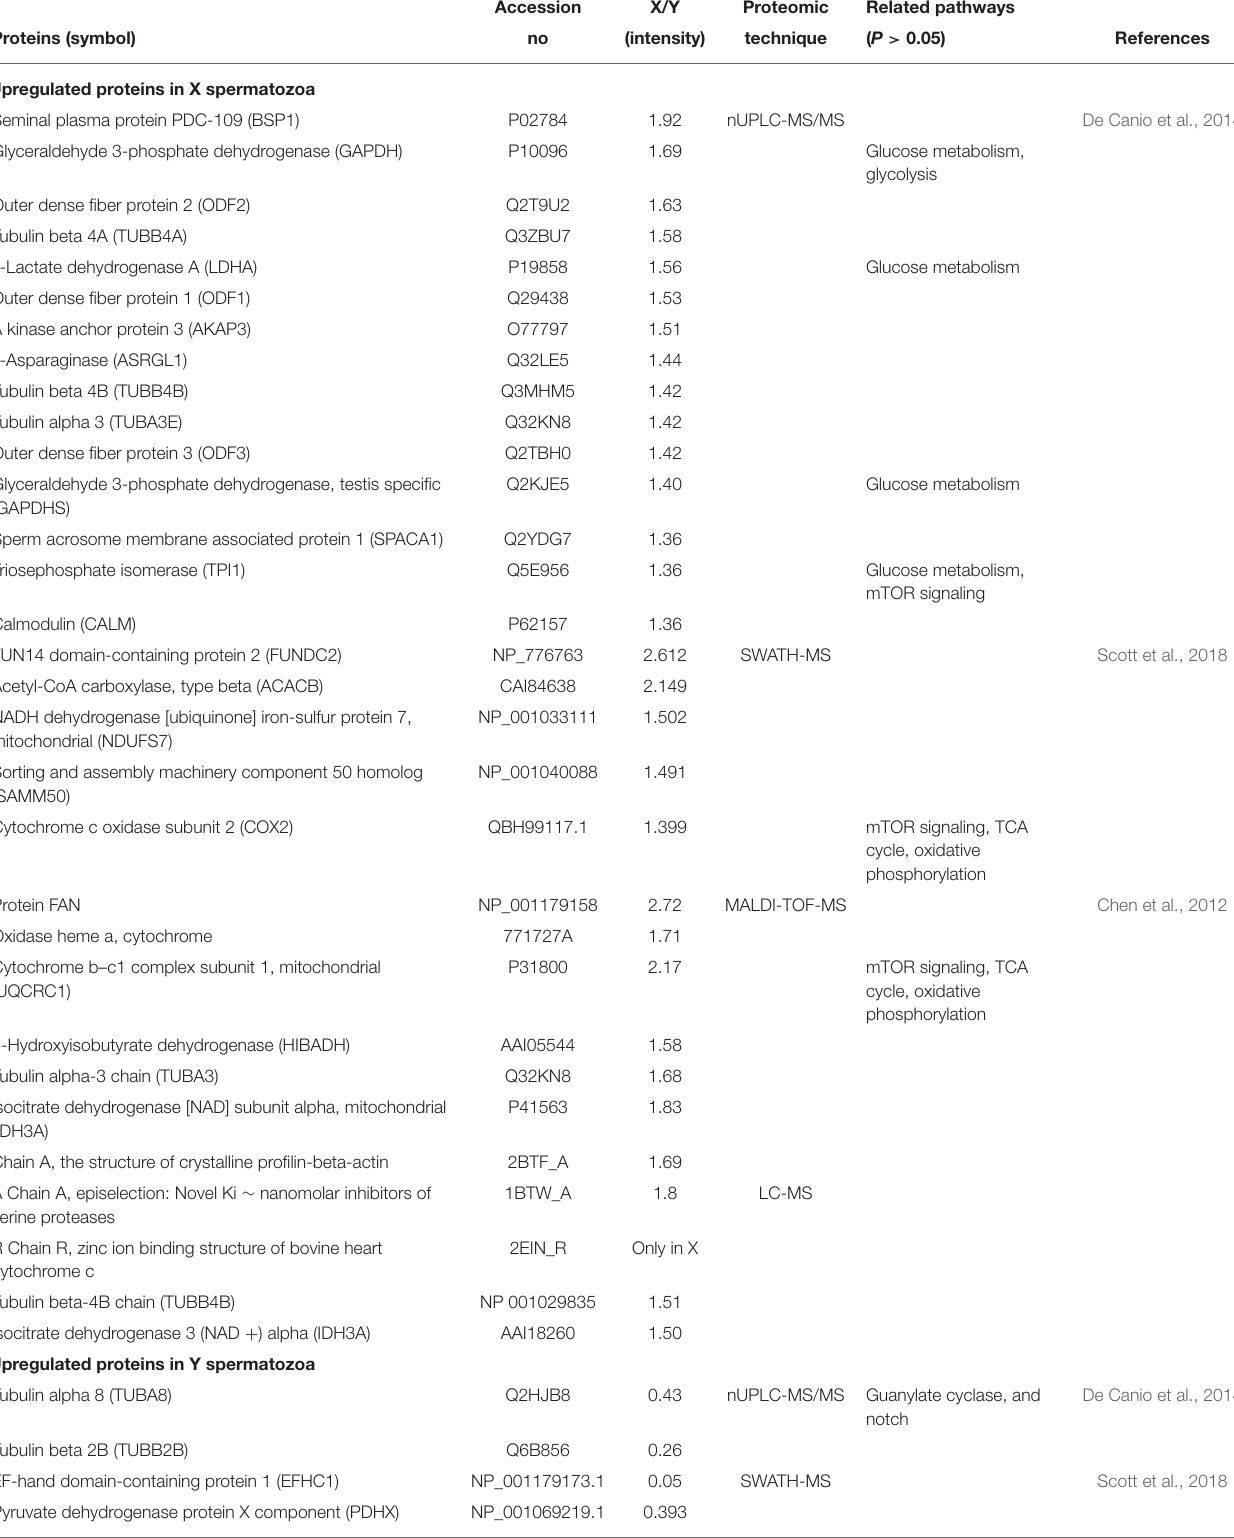
TABLE 4 | List of differentially expressed proteins in X and Y chromosome bearing spermatozoa. Accession X/Y Proteomic Related pathways Proteins (symbol)